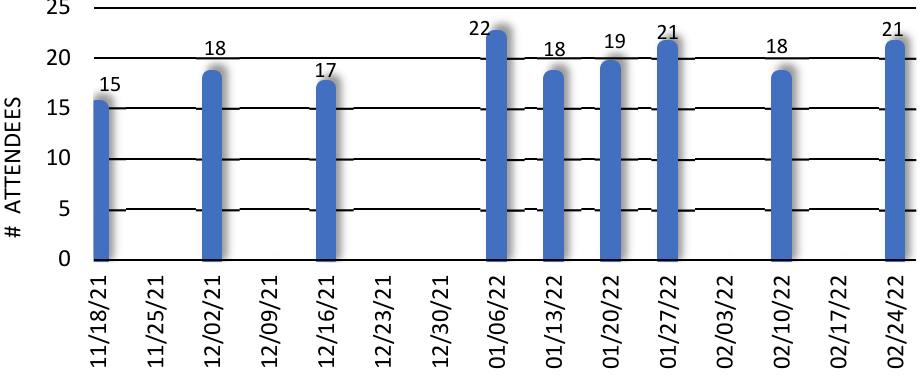
Figure 2. Number of attendees in RCMI Data Science Seminars.